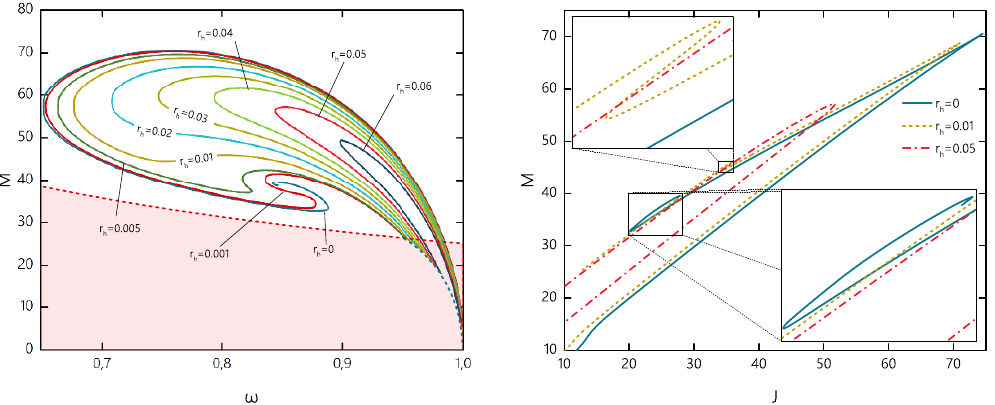
Figure 2 . ADM mass M vs. (left panel) the angular frequency ! or (right panel) the angular momentum J . Here m = 1 and (cid:11) = 0 : 5, whereas r h varies. In the left panel, the shaded area corresponds to the domain of existence of vacuum Kerr BHs, the red dashed line to the extremal vacuum Kerr BHs, and the blue dashed line to the existence line : the subset of vacuum Kerr